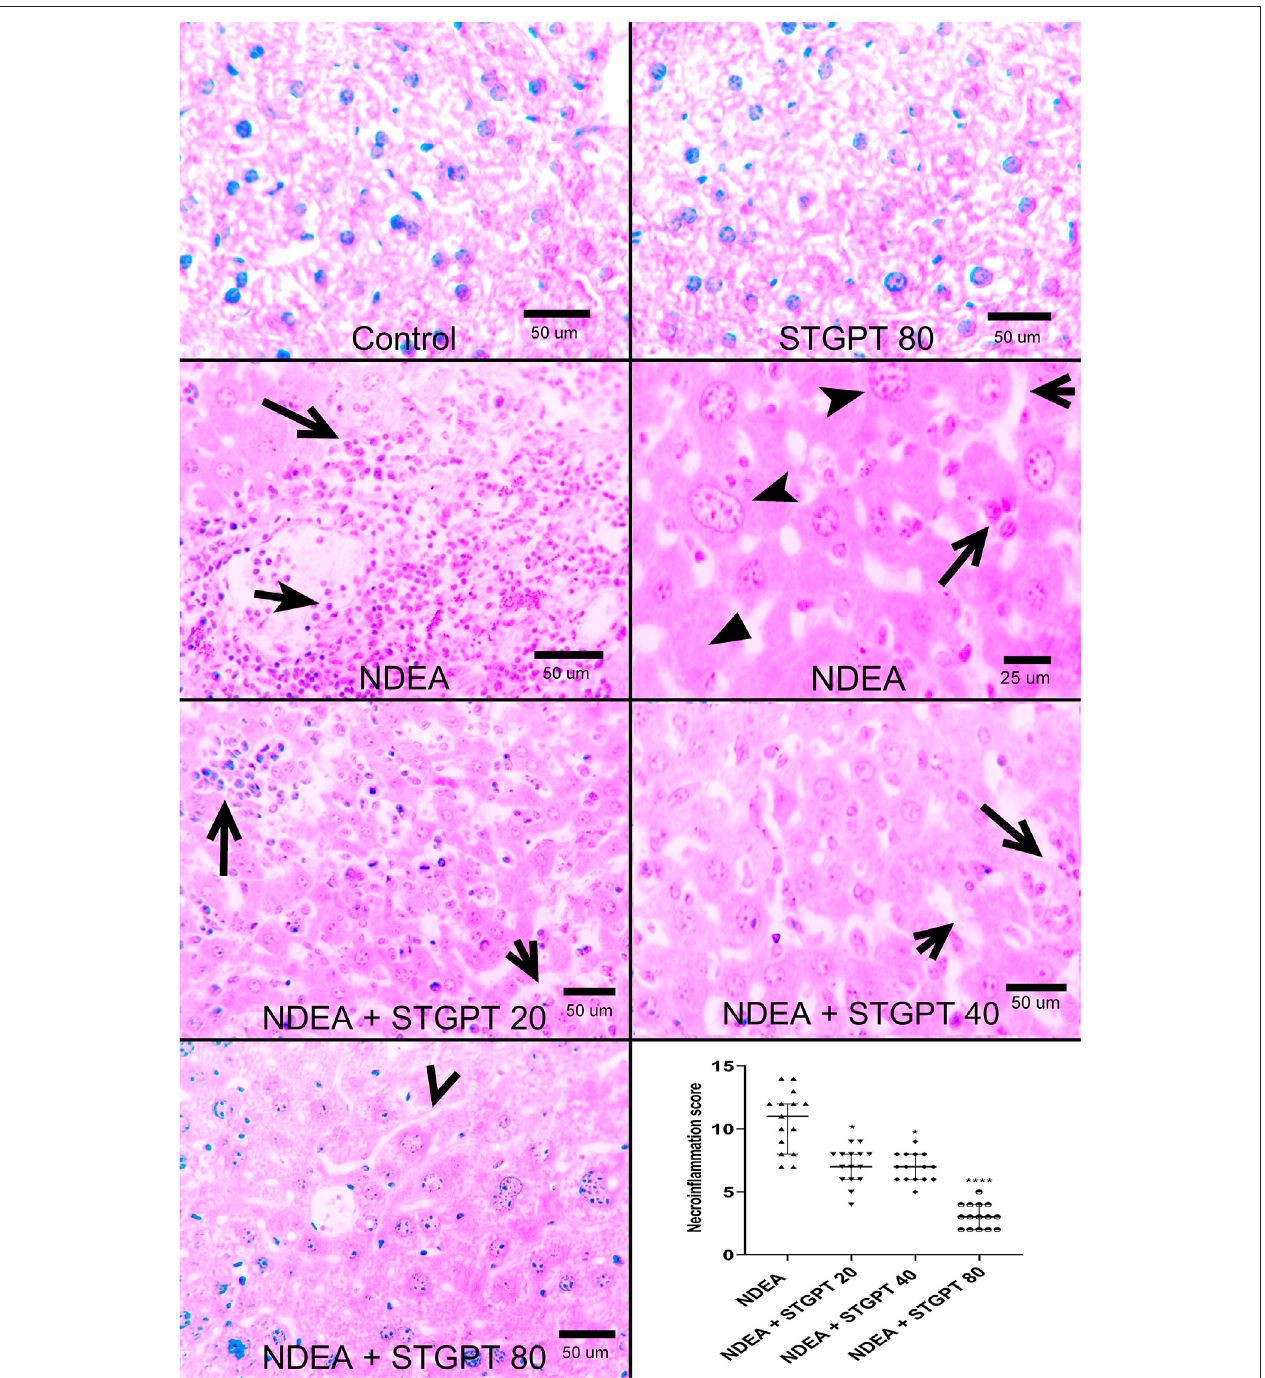
FIGURE 2 | Effect of STGPT (20, 40, and 80 mg/kg) on histopathological characteristics and necroin fl ammatory score in mice with NDEA-induced HCC. Representativehistologicalappearanceoflivertissue specimensfromControlandSTGPT 80showingnormal hepatic architecture; Liversections fromNDEAgroup(left and right panels) showing disrupted hepatic architecturedue tothedisorganization ofhepatic cords, dilatation ofhepatic sinusoids (shortopen arrow)with in fl ammatory cell in fi ltration (long open arrows), spotty necrosis ( fi lled arrowhead) and a great number of hepatocytes having large nuclei with prominent and multiple nucleoli (notched arrowhead); Liver sections from NDEA + STGPT 20 and NDEA + STGPT 40 (left panel and right panel, respectively) showing mild disruption of hepatic architecture with dilated sinusoids (short open arrow), decreased intralobular leukocyte in fi ltration (long open arrow), small number of hepatocytes having large nuclei; Liver sections from NDEA + STGPT 80 showing normal hepatic sinusoids (open arrowhead), decreased disorganization and restored hepatic architecture, very mild intralobular leukocyte in fi ltration, and diminished hepatocytes having large nuclei. H&E, Bar (cid:1) as indicated. Calculation of the necroin fl ammation score reveals